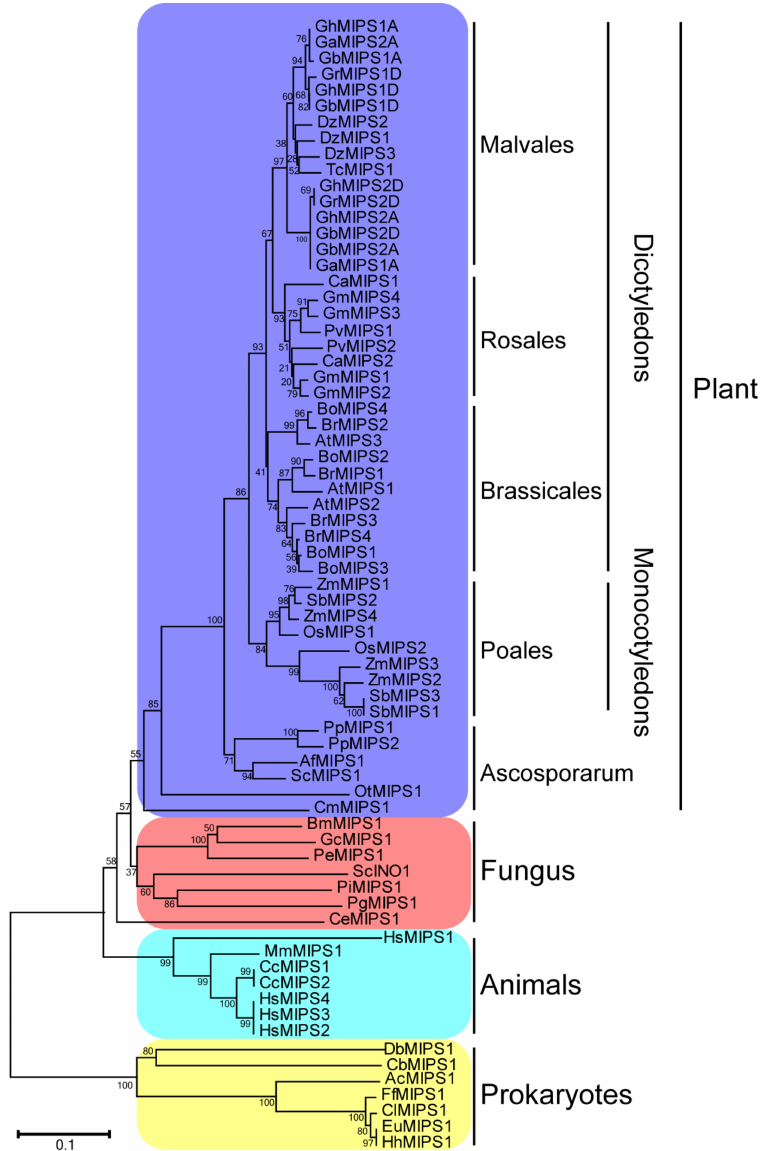
Figure 1. Phylogenetic tree of 70 MIPS homologues of 36 different species from prokaryotes to higher plants. See Supplementary Table S2 for detailed information of organism and protein